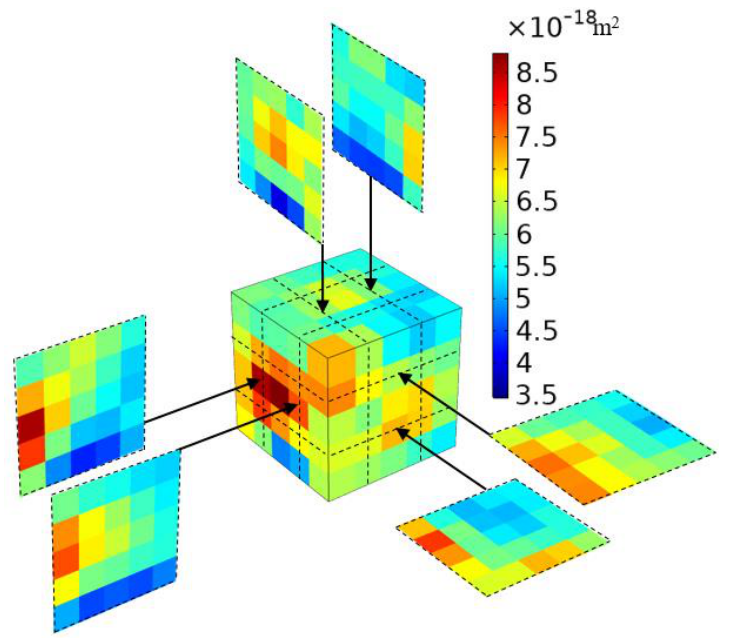
Figure 12. Spatial distribution of permeability within the cuboidal sample of Stanstead granite. ( Higher surface permeability records).